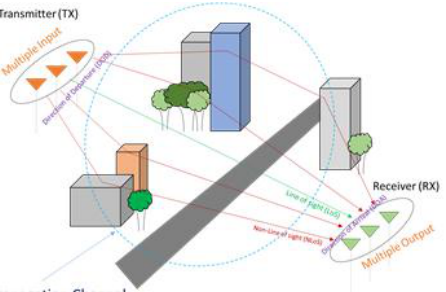
Fig. 1. Illustration of MIMO wireless communication